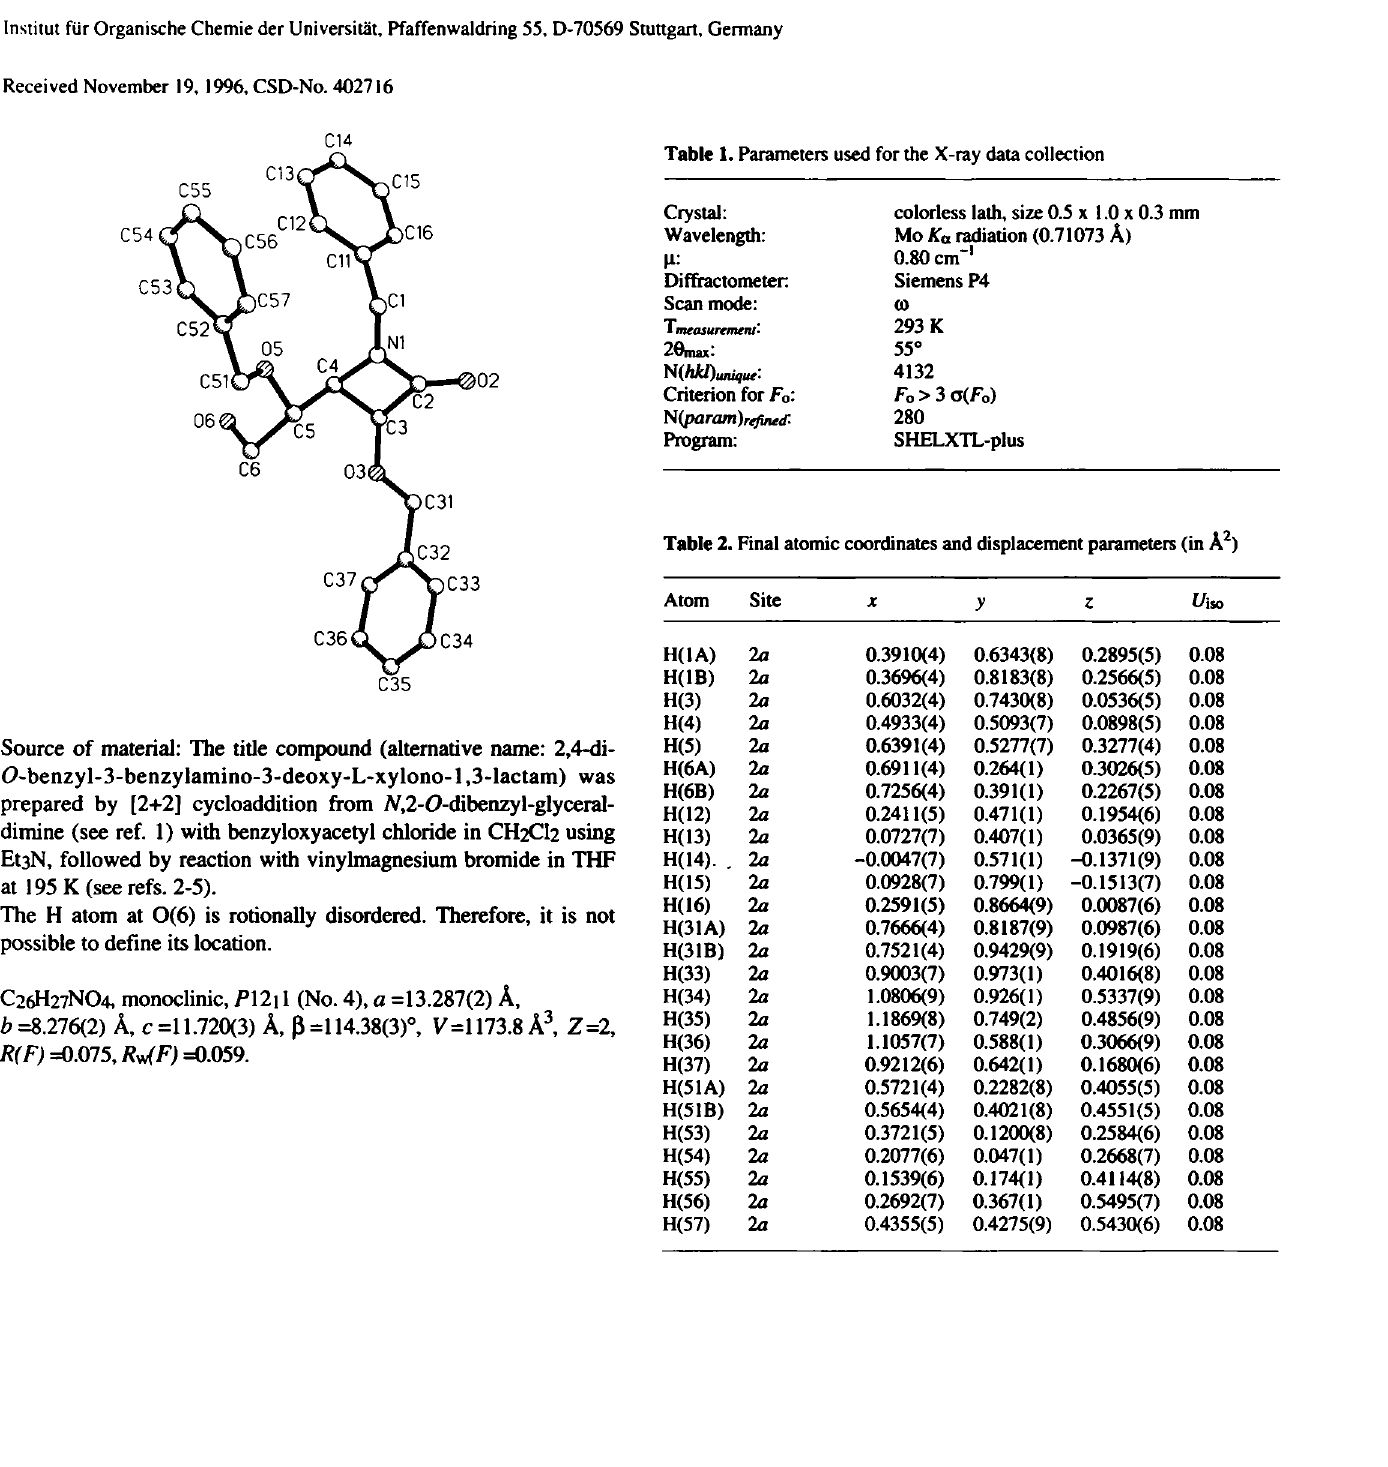
Table 1. Parameters used for the X-ray data collection